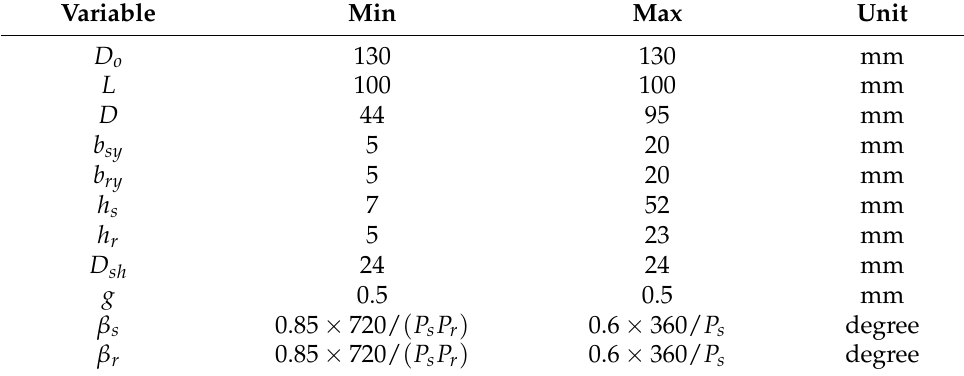
Table 2. Limits of